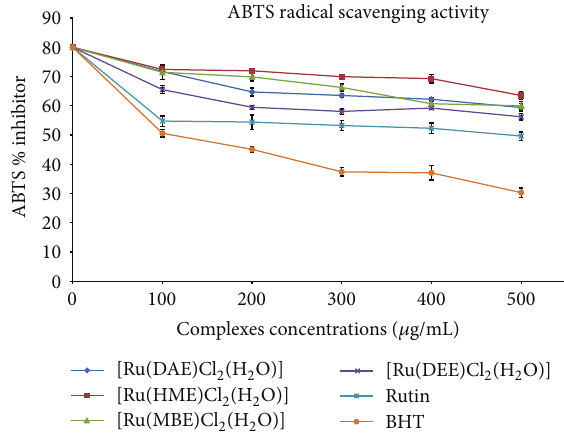
Figure 6: ABTS rummaging activity of Ru(III)-Schiff base com-